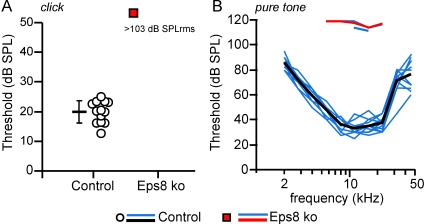
Auditory brainstem responses (ABR) in Eps8 mice.(A–B) ABR thresholds, obtained from control (13 ears from 7 mice: circles and black line) and Eps8 knockout (16 ears from 8 mice: red squares and red line) adult mice. ABR thresholds for broadband click (A) and frequency-specific pure tone stimulation (B) in Eps8 knockout mice were significantly higher than those in control mice (click and noise pulse p<0.001; pure tone p<0.001 between 5.6 and 22.3 kHz). Note that for frequency-specific ABR, threshold could only be determined in 3 ears from knockout mice (no thresholds were determined in all animals for click stimulation). Thresholds of individual ears are shown as circle and square symbols (click) and blue lines (pure tone). Black and red lines give the mean values. Responses to pure tone stimuli in knockout mice could only be recorded at high stimulus levels outside the normal physiological range (B: pure tone threshold 110–120 dB SPL).